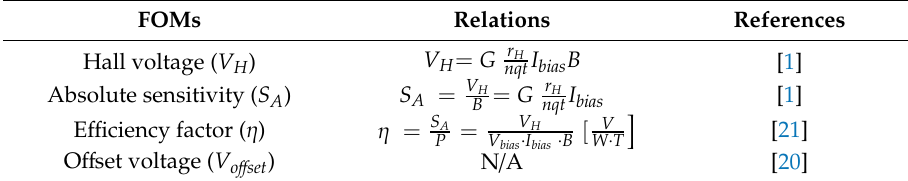
Table 1. The figure-of-merits (FOMs) definitions for Hall sensor 1